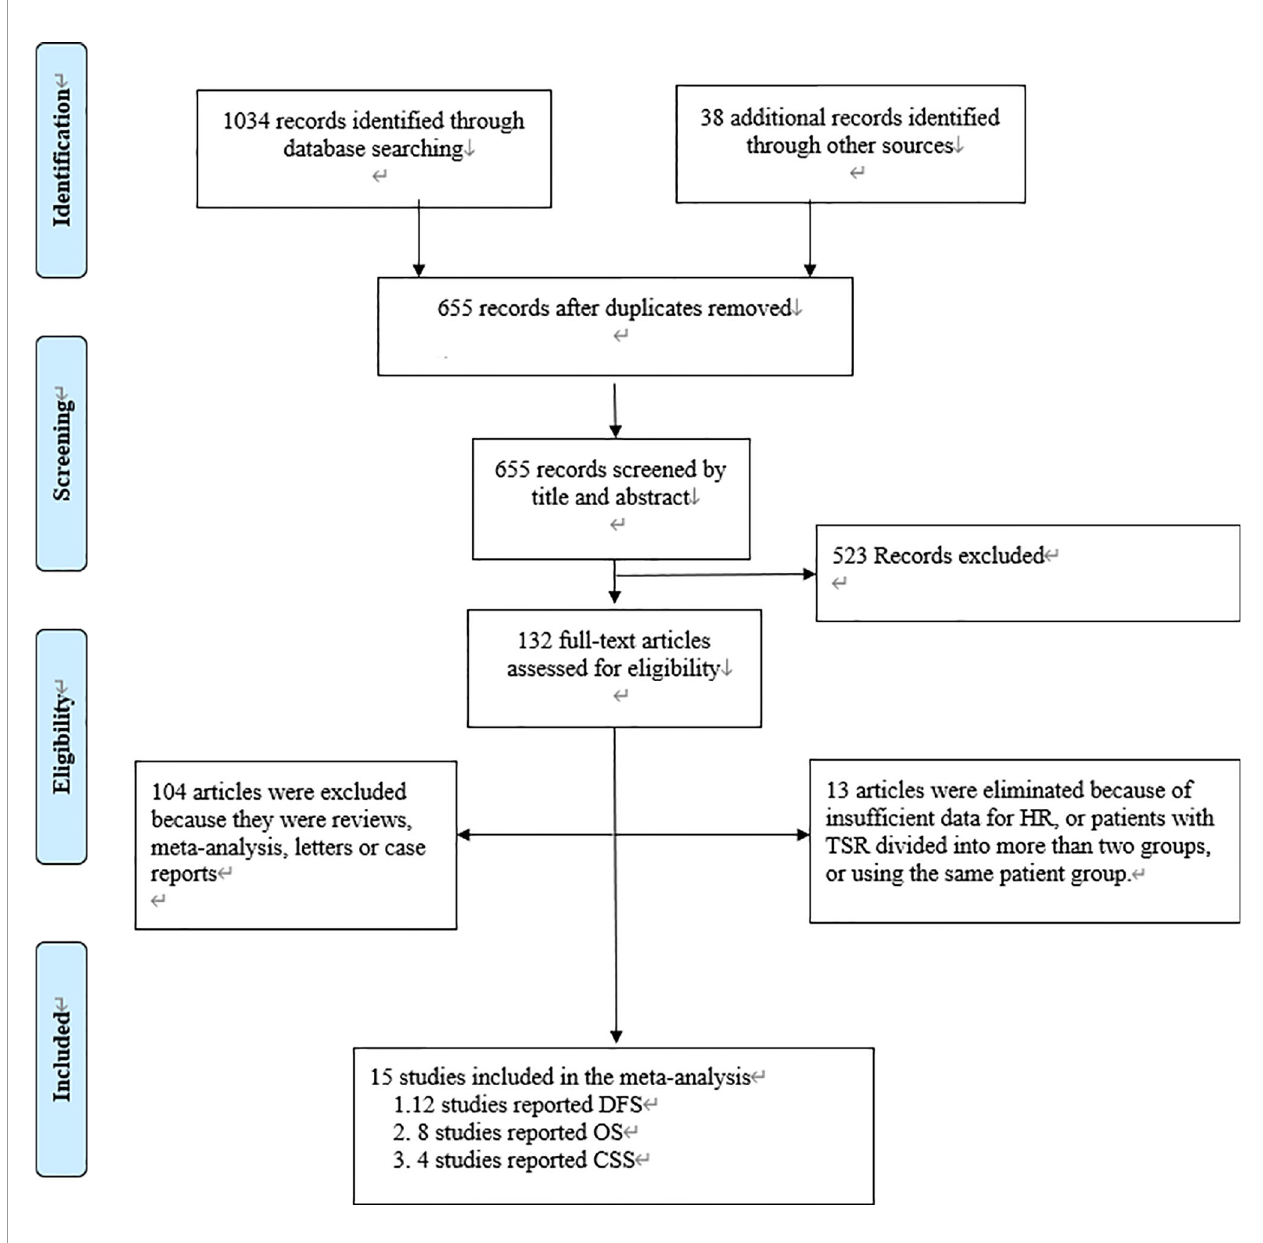
FIGURE 1 | Flowchart according to